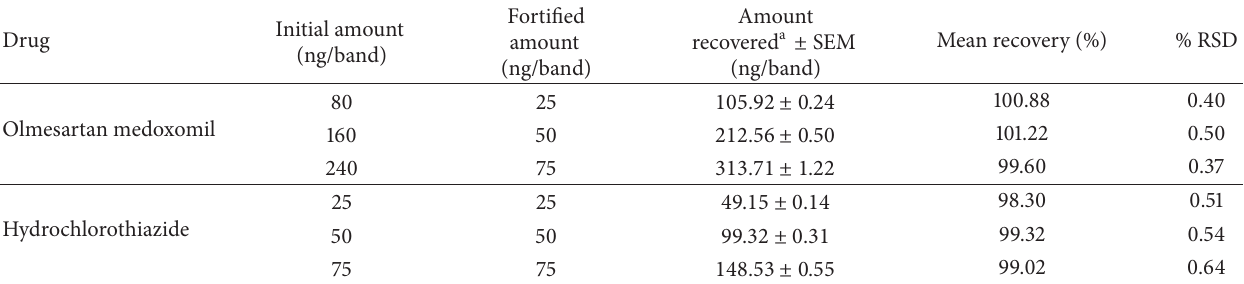
Table 3: Accuracy study by standard addition method.